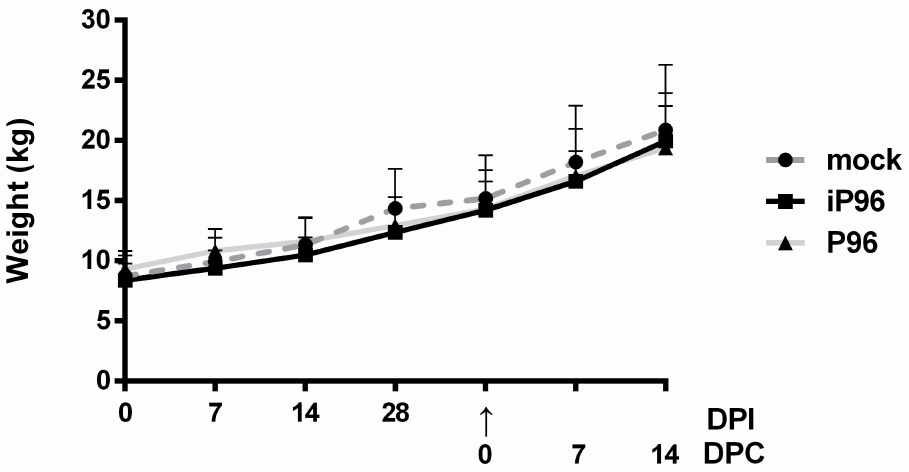
Figure 3. The weekly change in the mean body weight of 5-week-old piglets inoculated with the iPEDVPT-P96 virus ( (cid:4) ), the PEDVPT-P96 virus ( (cid:78) ), or mock-inoculated ( ) through the study. Each group consists of 5 piglets. The error bars indicated the standard deviation. The arrow indicated the time point (28 DPI or 0 DPC) of challenge with the PEDVPT-P5 virus. iP96: PEDVPT-P96; PEDVPT-P5; P96: PEDVPT-P96 virus; mock: PI medium control; DPI: days post-inoculation; DPC: days